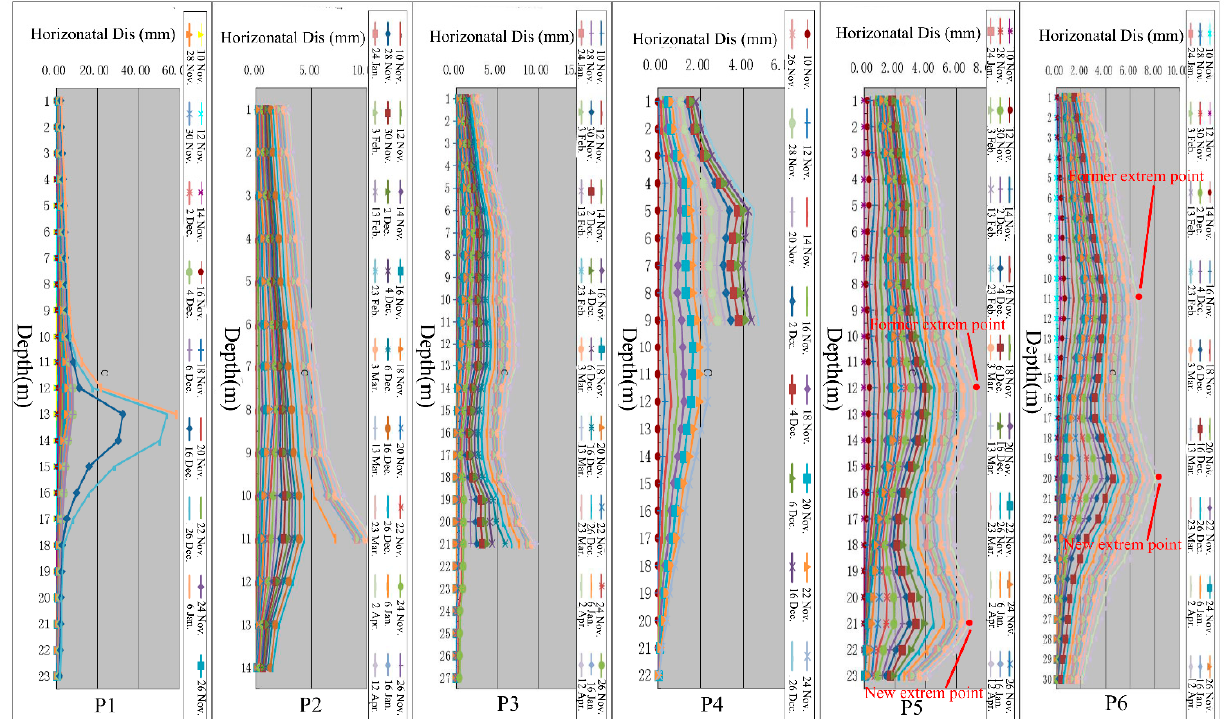
Figure 13. Monitoring of deep horizontal displacement before landslide treatment, from 10 November 2016 to 12 April 2017.